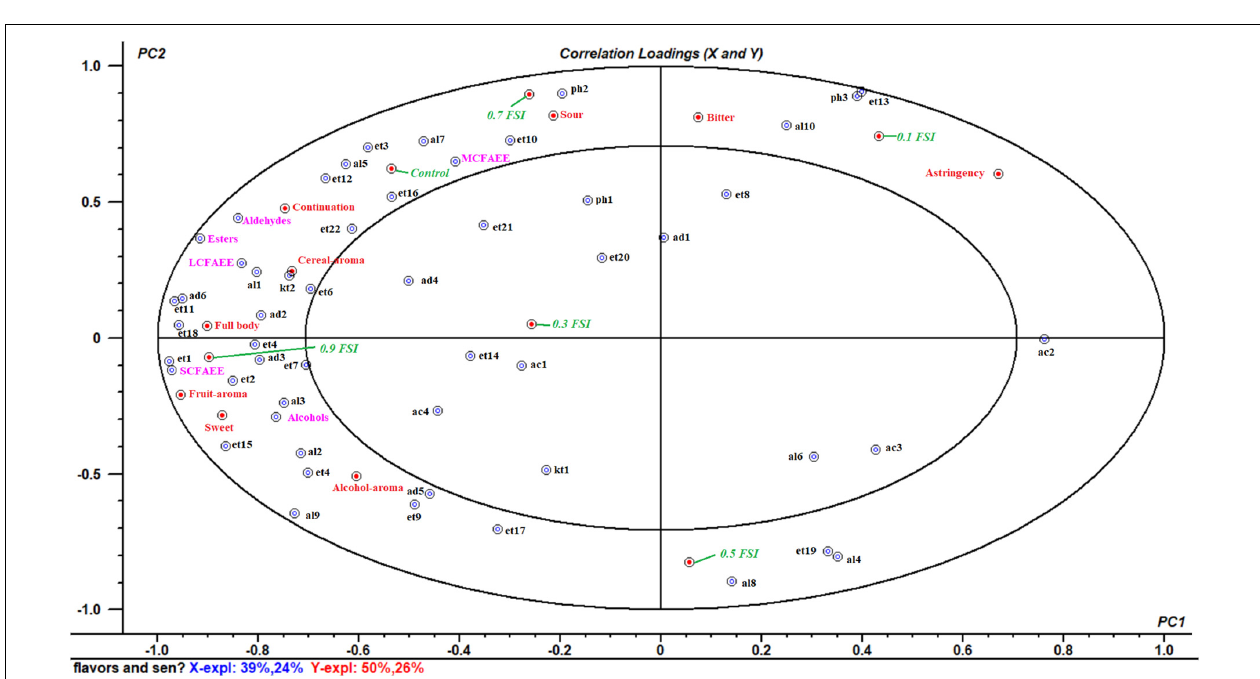
suggesting that the concentration of FSI had a significant effect on the sensory characteristic of the resultant HQW.